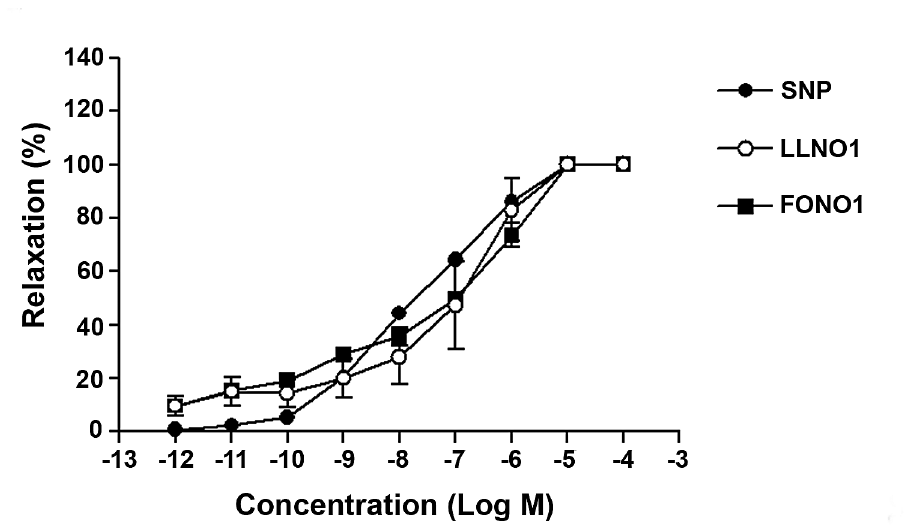
Figure 2 – Effect of LLNO1 upon aortic vascular endothelium rings. The rings were precontracted with 1 µ M phenylephrine and relax- ation concentration/response curves (concentrations graded from 10 -12 to 10 -3 M) were plotted for LLNO1 and compared with sodium nitroprusside curves. Findings are expressed as average ± standard error, based on six